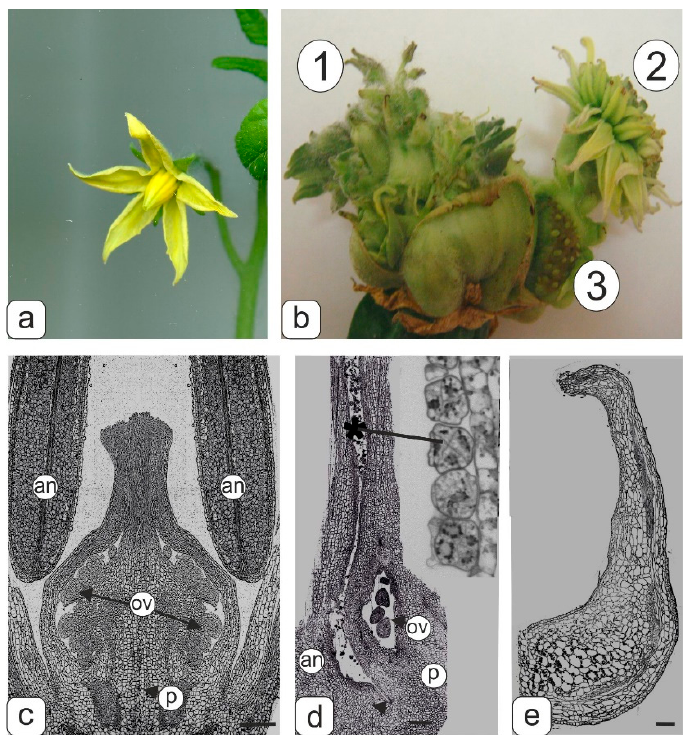
Figure 1. Flower phenotype of control and transgenic tomato plants and semi-thin longitudinal sections of control and abnormal transgenic tomato flowers fragments at the microsporogenesis initial stage. ( a ) Flower of control tomato line. ( b ) Flowers with abnormal morphology of transgenic tomato lines formed from abnormal fruit; secondary flower formed at the base of the primary ovary in the transgenic tomato line: 1–upper small flower buds at abnormal multitier tomato fruit; 2–flowers assembled in pseudo inflorescences; 3–sterile seed buds. ( c ) Middle section of pistil and stamens in control tomato line. ( d ) Accreted pistil and stamen from pseudo inflorescences. Abnormal microspore tetrads (asterisk) are visible inside the pollen sac of the anther. ( e ) Abnormal stamen. Symbols: an–anther; ov–ovules, p–pistil. Bar—500 μ m (c); 200 μ m (d,e).